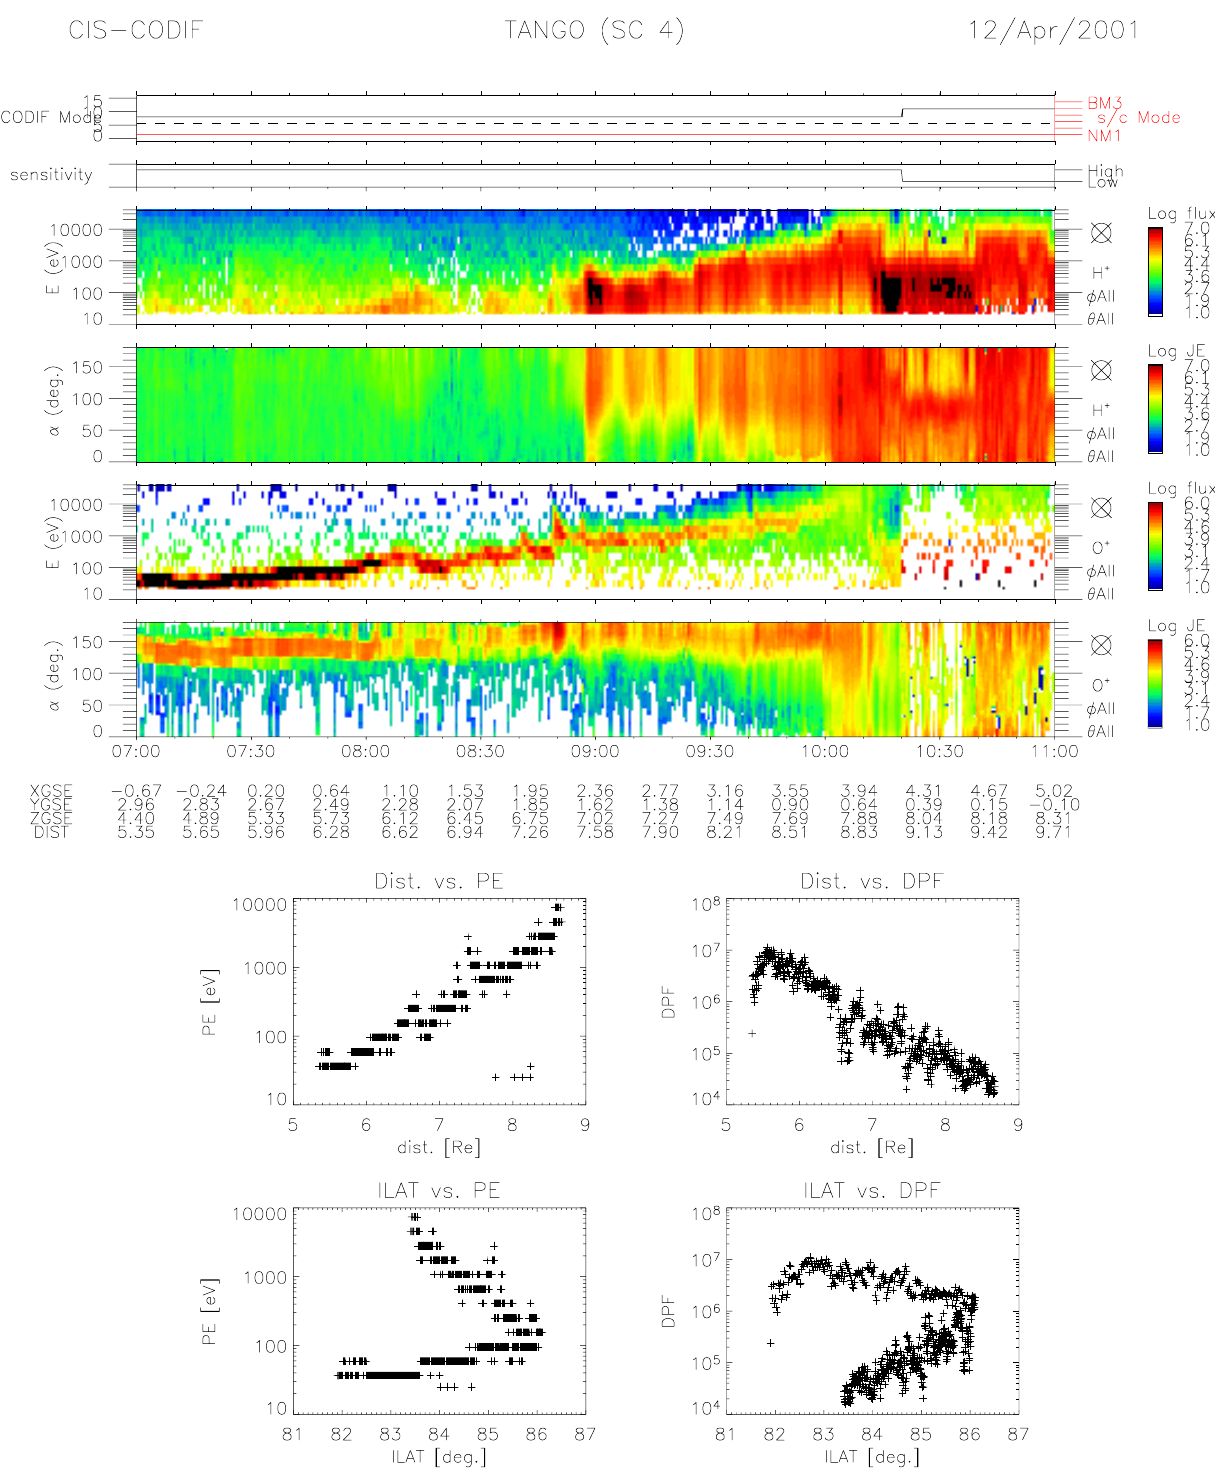
Fig. 1. Sample data on 12 April 2001. Upper panel: There are 6 panels and the first two panels from the top are detection mode and sensitivity of the CIS/CODIF instrument. Regarding the 3rd − 6th panel from the top, time-energy spectrogram of H + given by flux (part/(cm 2 · s · sr · keV)), time-pitch angle distributions (PADs) of H + given by energy flux, JE (keV/(cm 2 · s · sr · keV)), and time-energy spectro- gram and time-PADs of O + . The observation time interval of field-aligned upgoing (or outflowing) O + ions is selected between 07:00 and 10:00 UT. (Bottom panel) The energy (eV) of maximum differential particle flux (abbreviated to PE hereafter) and the maximum differential particle flux ( MDPF (part/(cm 2 · s · sr · keV))) of field-aligned upgoing O + (12 April 2001, 07:00–10:00 UT) as functions of geocentric distance and invariant latitude